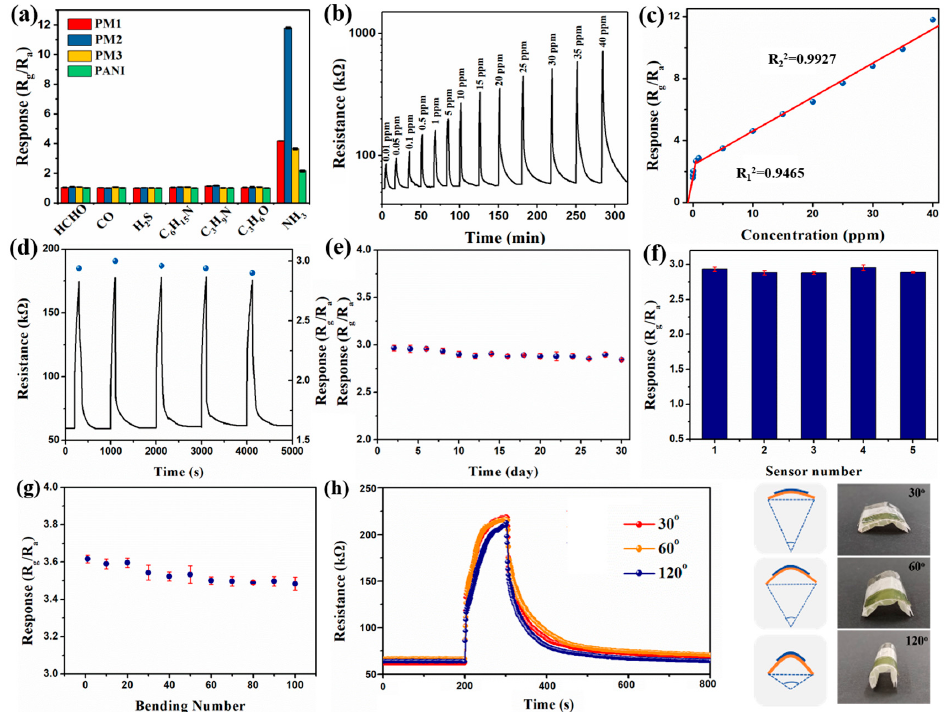
Figure 4. The response of sensors to 40 ppm of various gases ( a ); the response–recovery curve ( b ) and the response value ( c ) of PM2 sensor to 0.01–40 ppm NH 3 ; the reproducibility ( d ), the long-term stability ( e ) and the sensor numbers ( f ) of PM2 sensor; the effect of bending number ( g ) and bending angle ( h ) on response to 5 ppm NH 3. Table 1. NH 3 sensing performances of gas sensors based on PANI/MWCNTs materials.